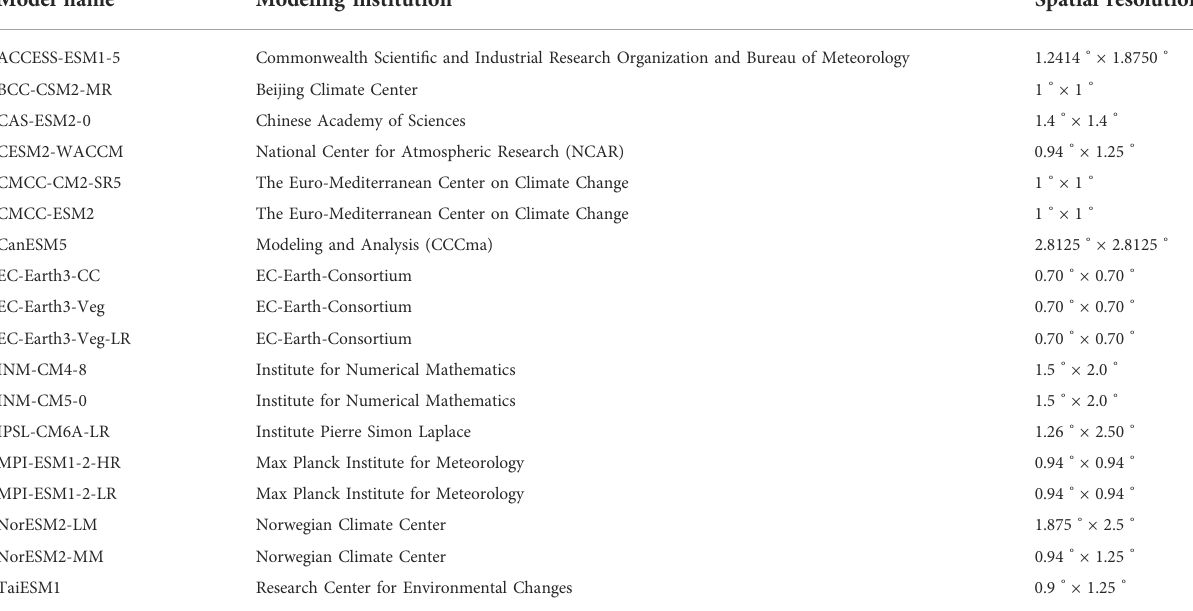
TABLE 1 The detailed information of 18 CMIP6 ESMs that are used for historical and future (SSP2-RCP4.5) analyses.